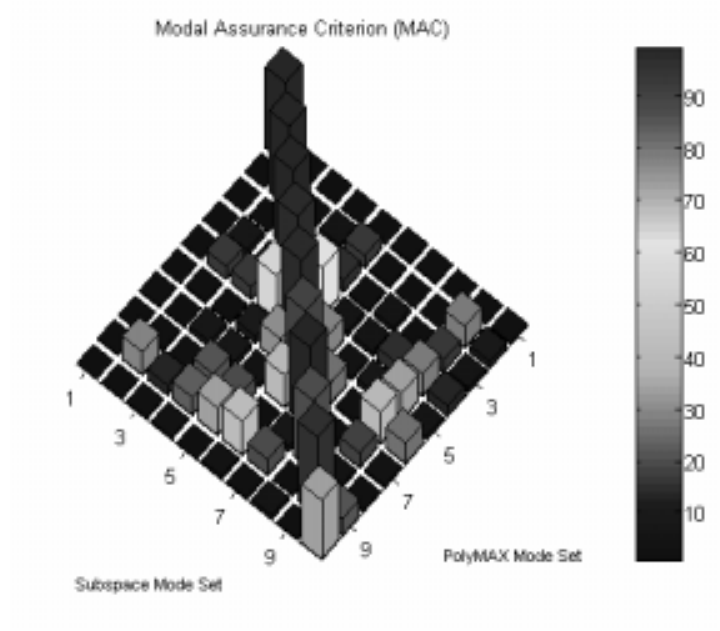
Fig. 12. MAC values assessing the mode shape correlation between SSI and PolyMAX mode